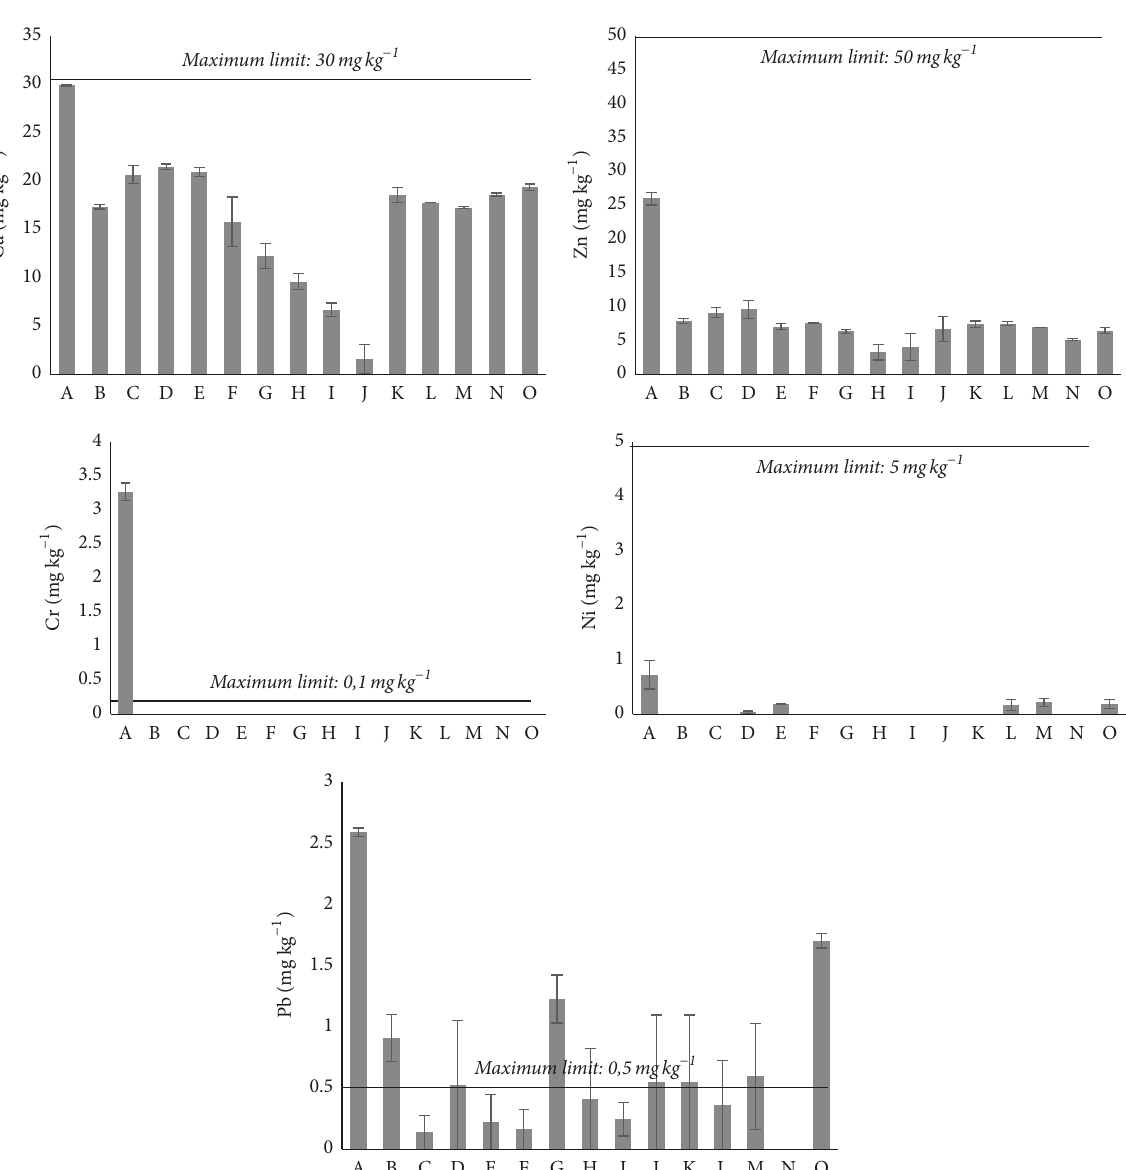
Pb was undetectable only in one sample. The Pb con- tents ranged from 0.14 to 2.59 mg kg −1 , having a mean